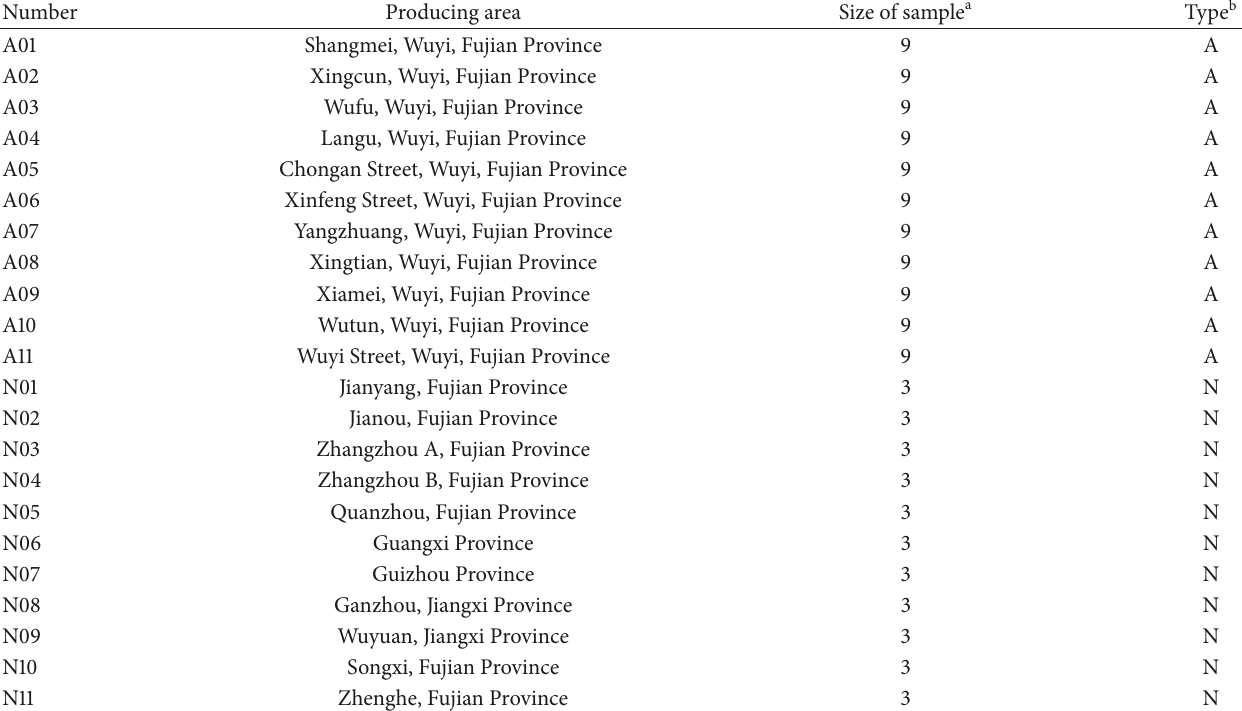
Table 1: Detailed information of the